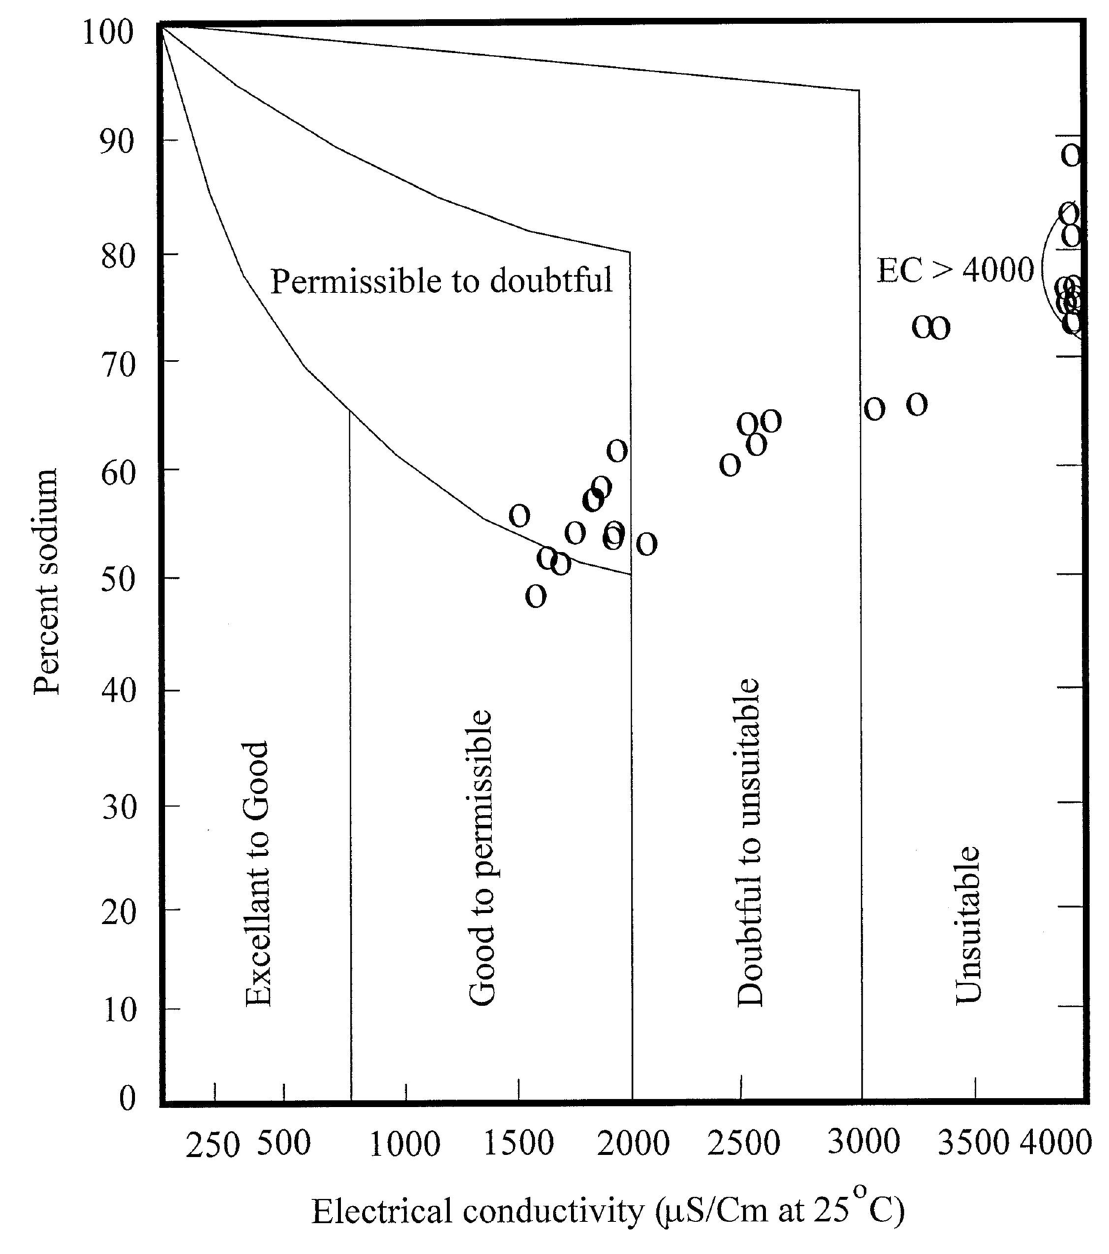
Fig. 8 Groundwater quality for irrigation (after Wilcox